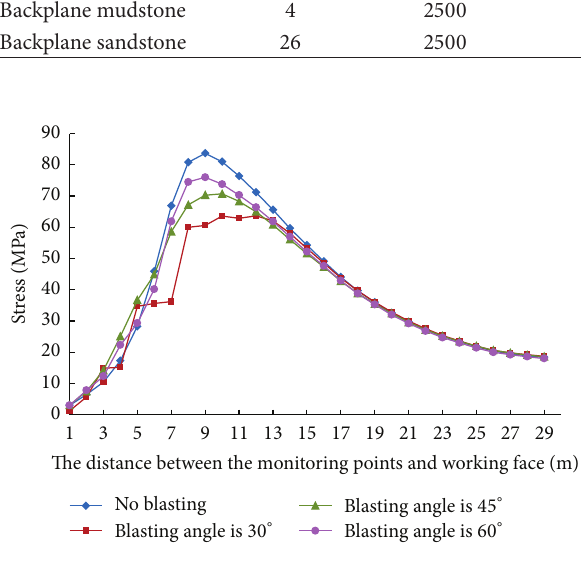
Figure 2: The changing curve of side-abutment pressure.